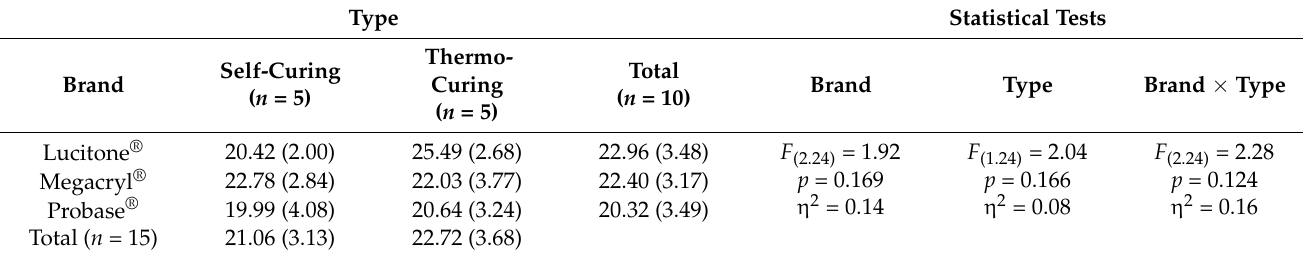
Table 2. Bifactorial ANOVA for the comparison of the average values of fracture torque by brand and type of resin.